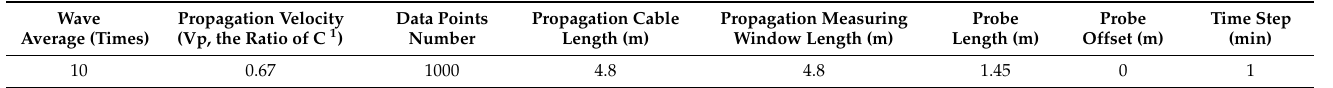
Table 2. The physical settings of FRC sensors in the TDR waveform logging program. Wave Propagation Velocity Average (Times) (Vp, the Ratio of C 1